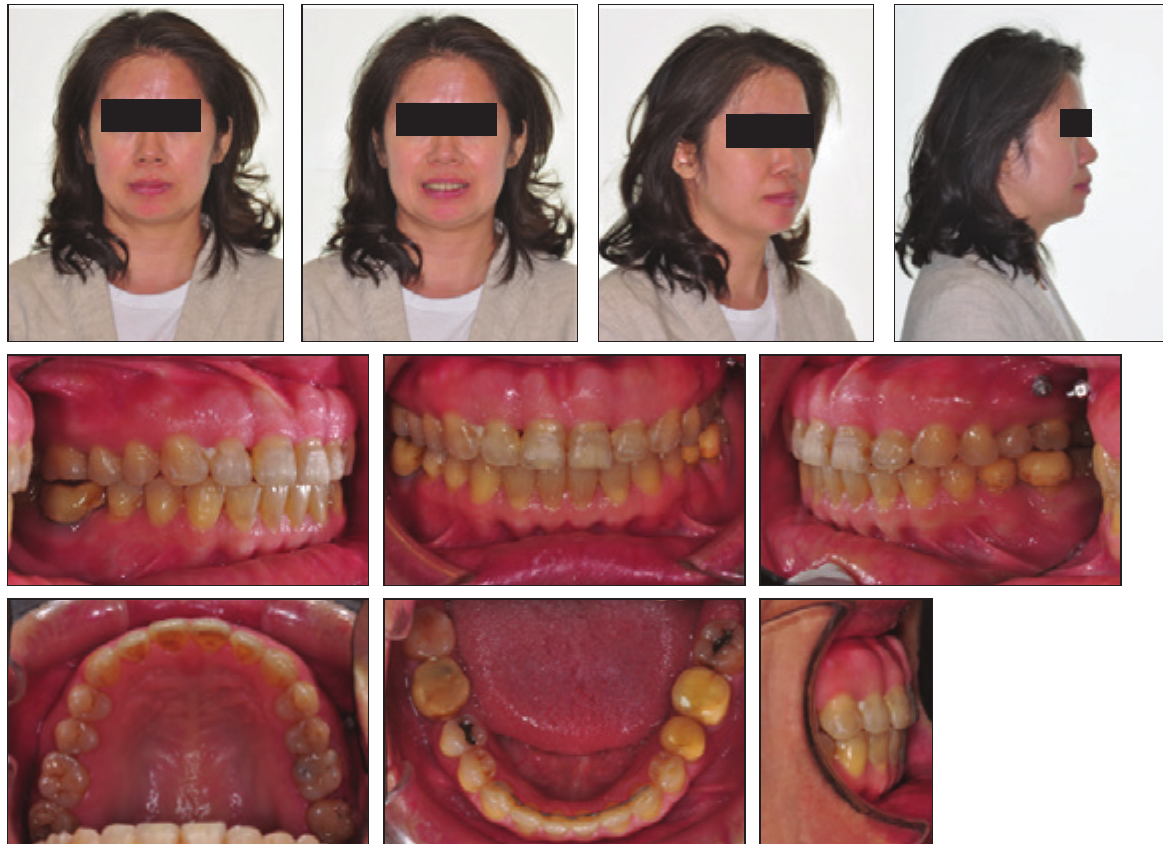
Figure 4. The total orthodontic treatment duration was three years and two